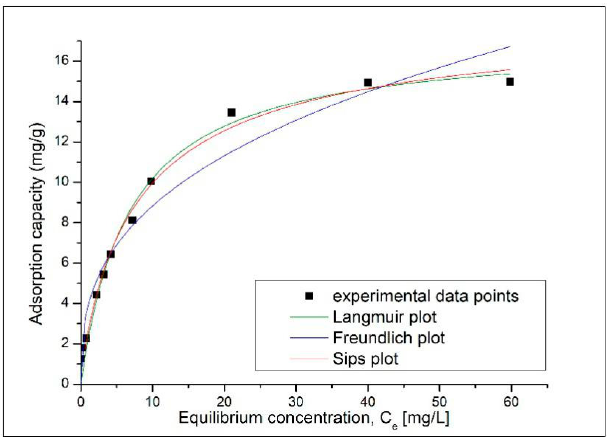
Figure 11. Adsorption isotherm of Pb 2 + onto magnetic nanocomposite MNPs35@SiO 2 .